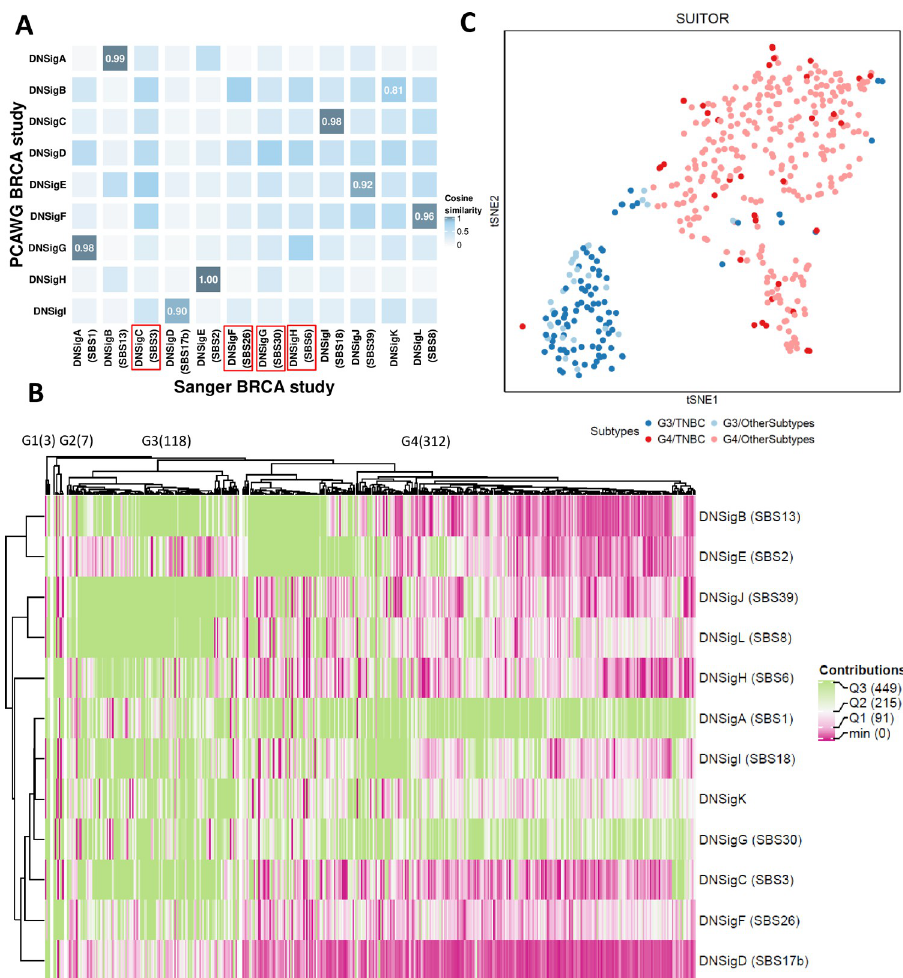
Fig 6. The results of Sanger breast cancer study by SUITOR. a) The heatmap of cosine similarity between de novo signatures detected in the PCAWG breast cancer (BRCA) study and de novo signatures in the Sanger BRCA study. The signatures of the Sanger BRCA study are annotated by COSMIC signatures (if cosine similarities > 0.8) among parentheses. For example, DNSigA (SBS1) refers to de novo signature A (DNSigA) being annotated by COSMIC signature SBS1. The four signatures which were detected in the Sanger BRCA study only were annotated by the red rectangular frames around the names of signature. b) The heatmap of signature activities estimated by SUITOR with hierarchical clustering in the Sanger BRCA study. The number of tumors included in each signature cluster is shown among parentheses on the top of the heatmap. Q1, Q2, Q3: the 1st, 2nd and 3rd quantiles of signature activities. c) The t-SNE visualization of tumors in G3 and G4 signature clusters, color-coded by signature clusters and molecular subtypes. TNBC: triple negative breast